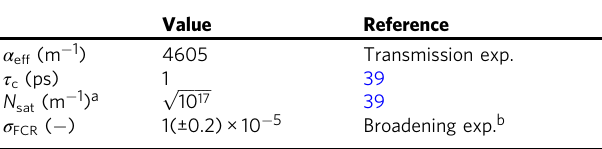
Table 1 Values of the parameters in Eqs. (4 – 6) for graphene- covered SiO 2 -core